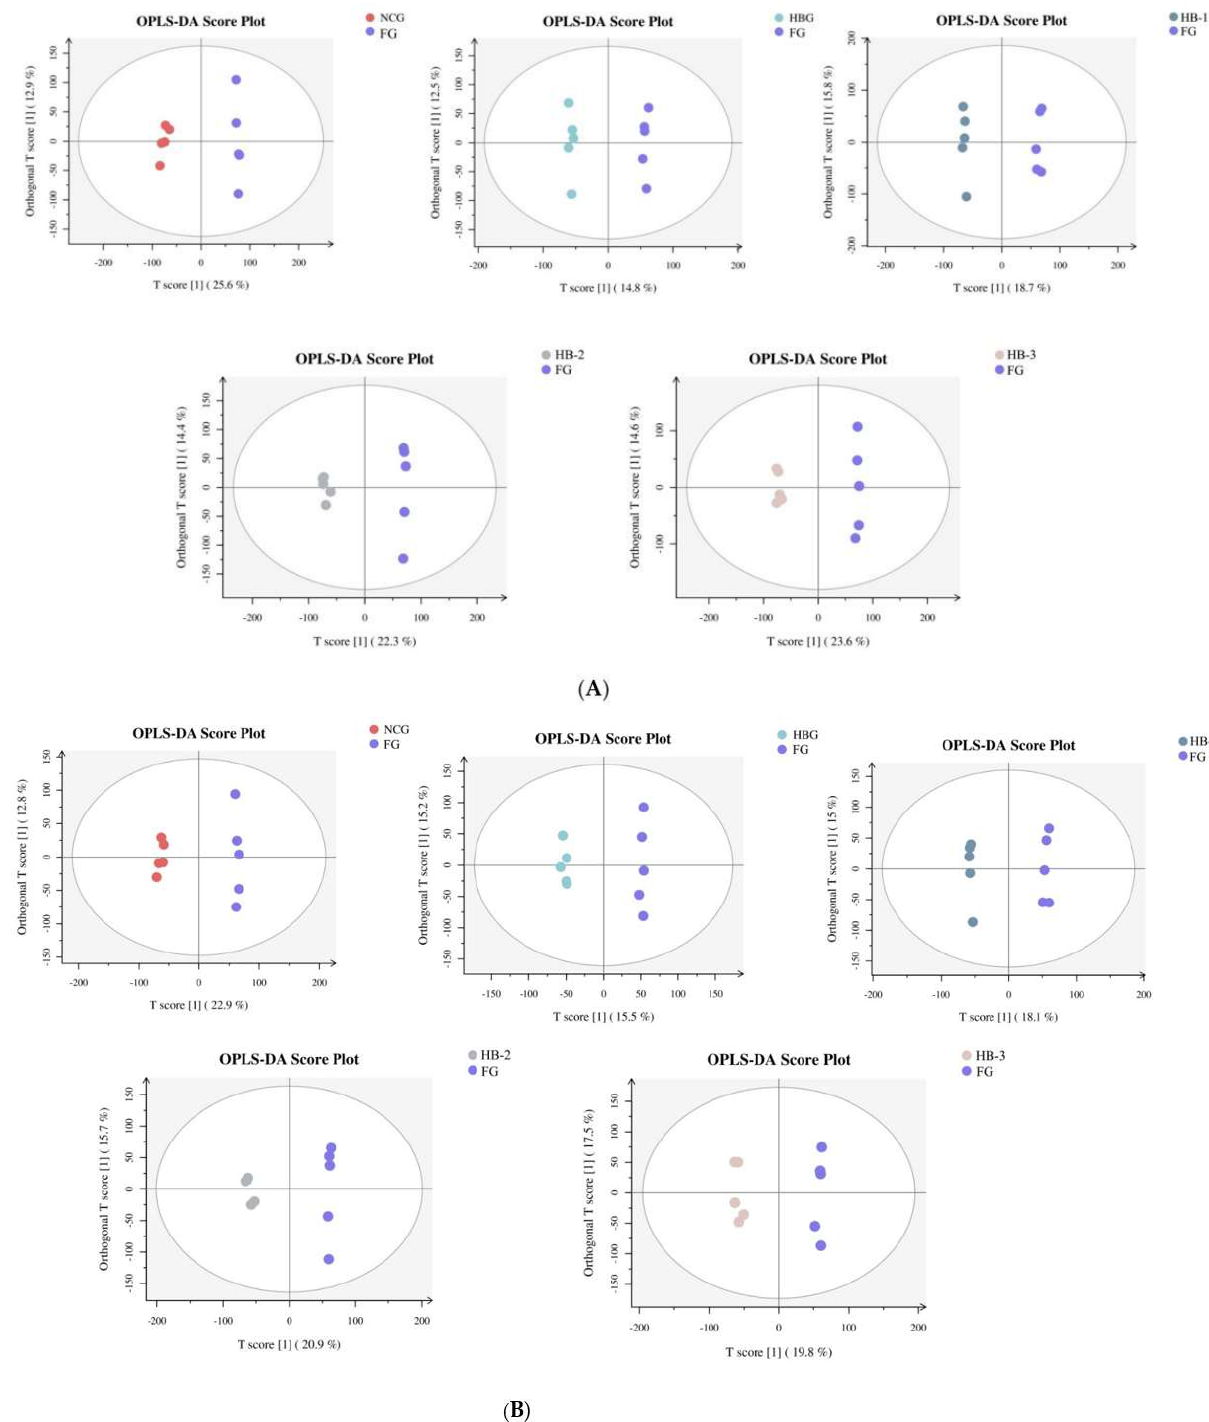
Figure 6. Orthogonal partial least squares discriminant analysis (OPLS-DA) score plots of the metabolome was visualized as follows: OPLS-DA in NCG vs. FG, HBG vs. FG, HB-1 vs. FG, HB-2 vs. FG, HB-3 vs. FG in ESI+ ( A ), and in ESI- ( B ).